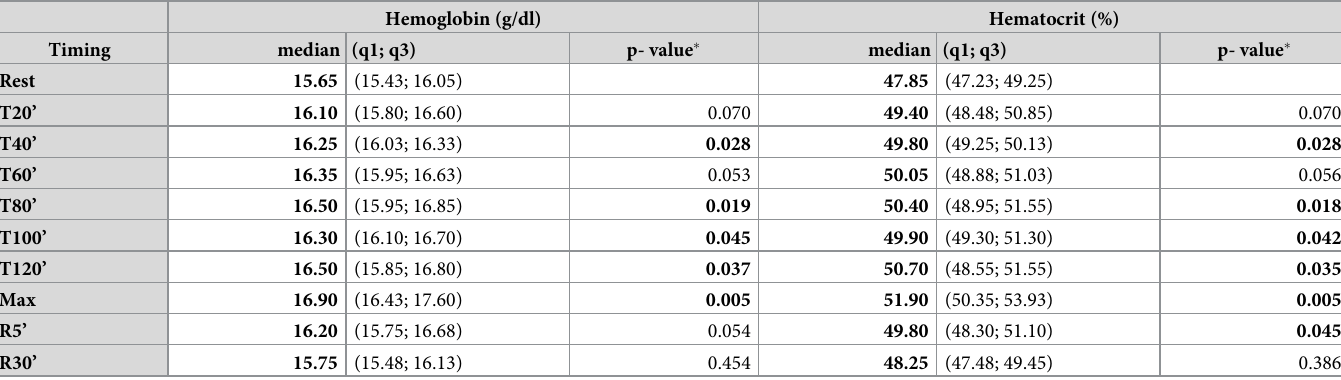
Table 1. Hemoglobin and hematocrit values during the long, dehydration